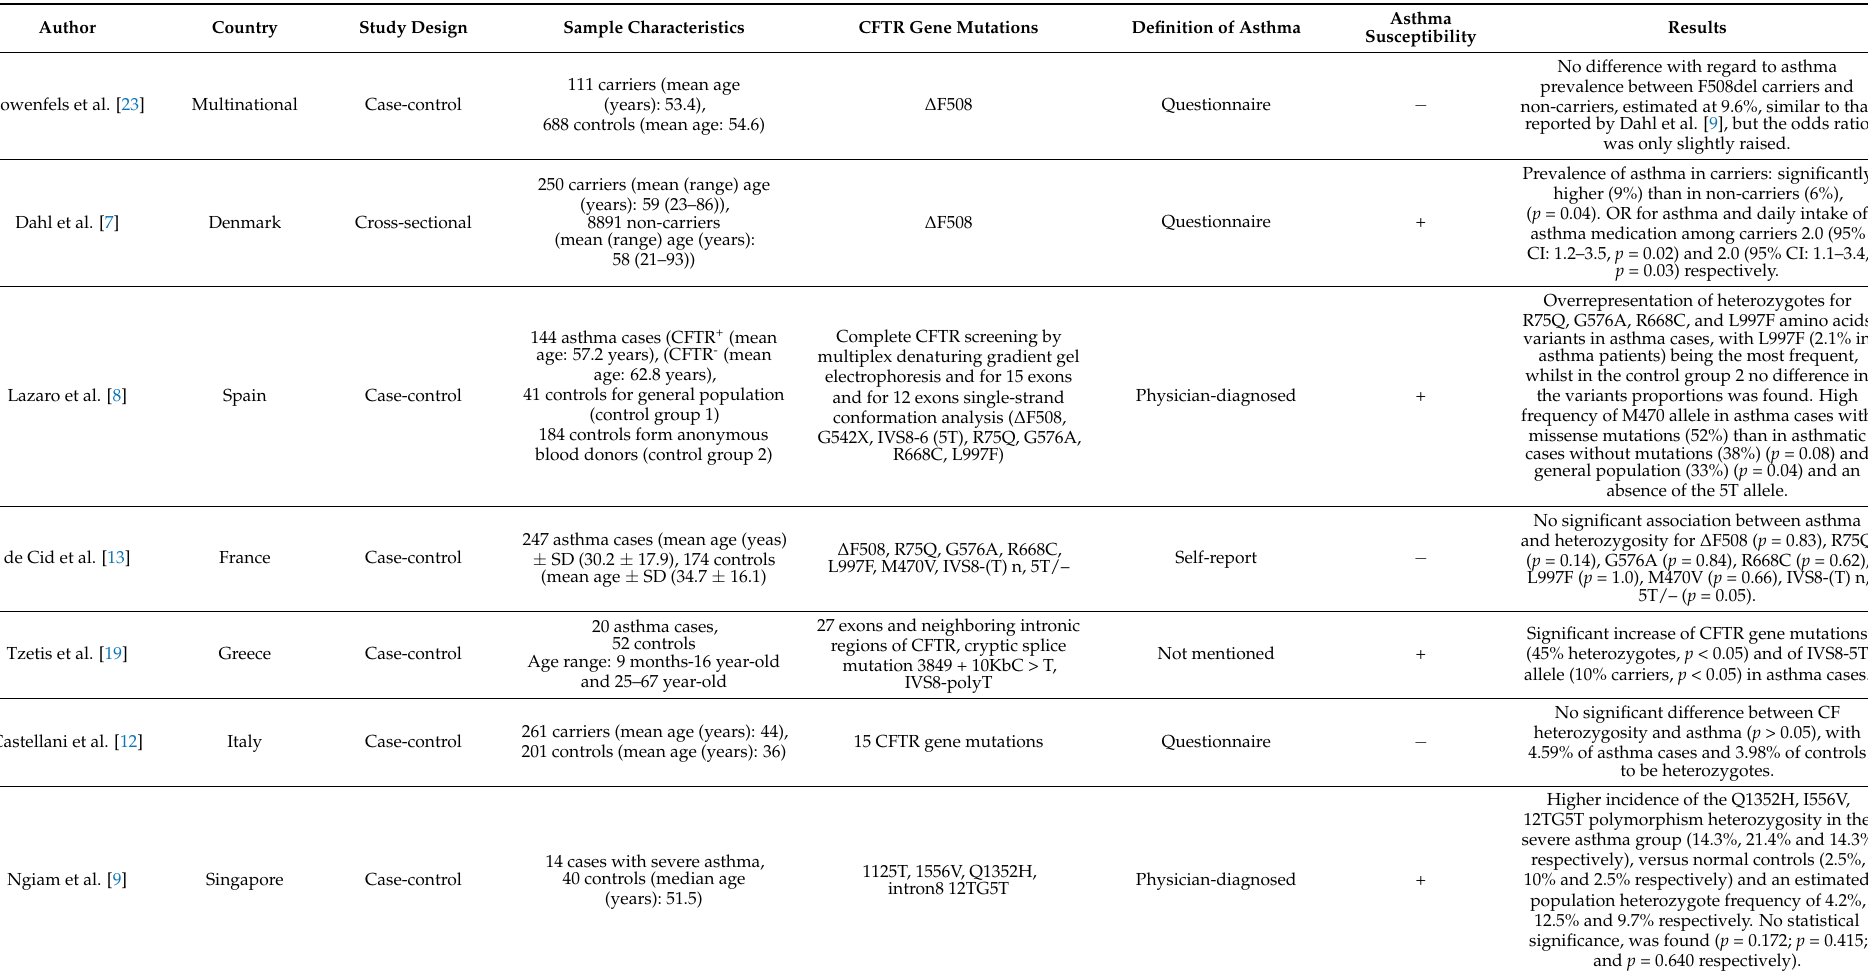
Table 1. Characteristics of the included